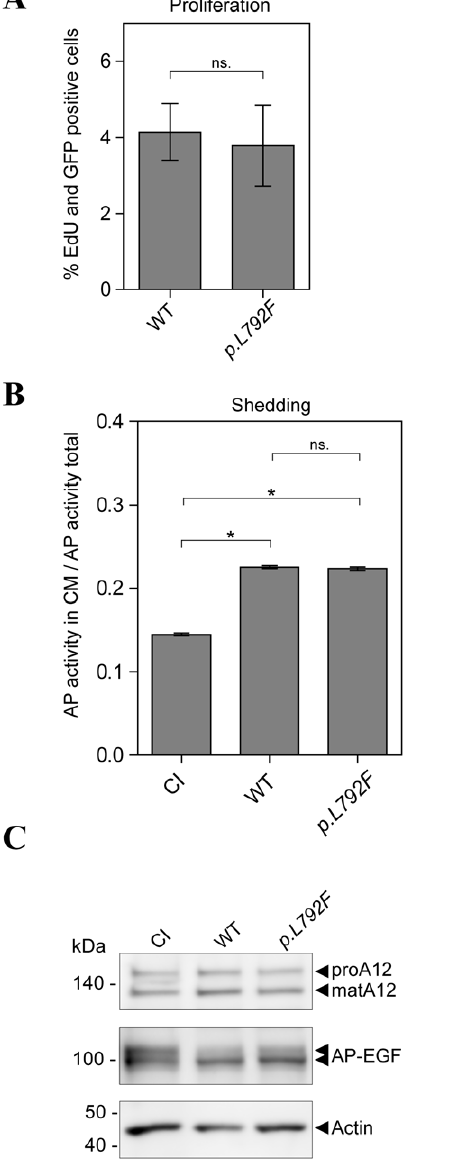
Figure 4. ADAM12 p.L792F does not affect cell proliferation or EGF shedding. ( A ) Comparable proliferation of ADAM12 WT and ADAM12 p.L792F expressing cells. 293VnR cells transiently transfected with ADAM12-GFP or ADAM12-GFP p.L792F were plated on FBS-coated coverslips in triplicates. Proliferating cells were stained with Edu. Four images were taken from each triplicate and EdU- and GFP-positive cells were calculated as percentage of total cells (DAPI staining). The data are shown as + / 2 standard error of the mean (SEM) (n=2 independent experiments performed in triplicates); ‘‘ns.’’ indicates no statistical difference (p . 0.05, two-tailed unpaired t-test). ( B ) ADAM12 p.L792F does not affect ADAM12-mediated proEGF shedding. 293VnR cells were transiently transfected with alkaline phosphatase (AP)-tagged proEGF together with ADAM12-GFP WT, CI ADAM12-GFP, or ADAM12 p.L792F ( p.L792F ). EGF-shedding was calculated from the ratio of AP activity in the cell media to total AP activity in the media and corresponding cell lysate, corrected for background (sample without AP substrate) (n=2 independent experiments performed in triplicate). * indicates a statistically significant difference (p , 0.0001, two-tailed unpaired t-test) and ‘‘ns.’’ indicates no statistical difference (p . 0.05). ( C ) Representative western blot of protein expression control from experiment in ( B ). Transfected 293VnR cells were lysed in RIPA buffer and analyzed